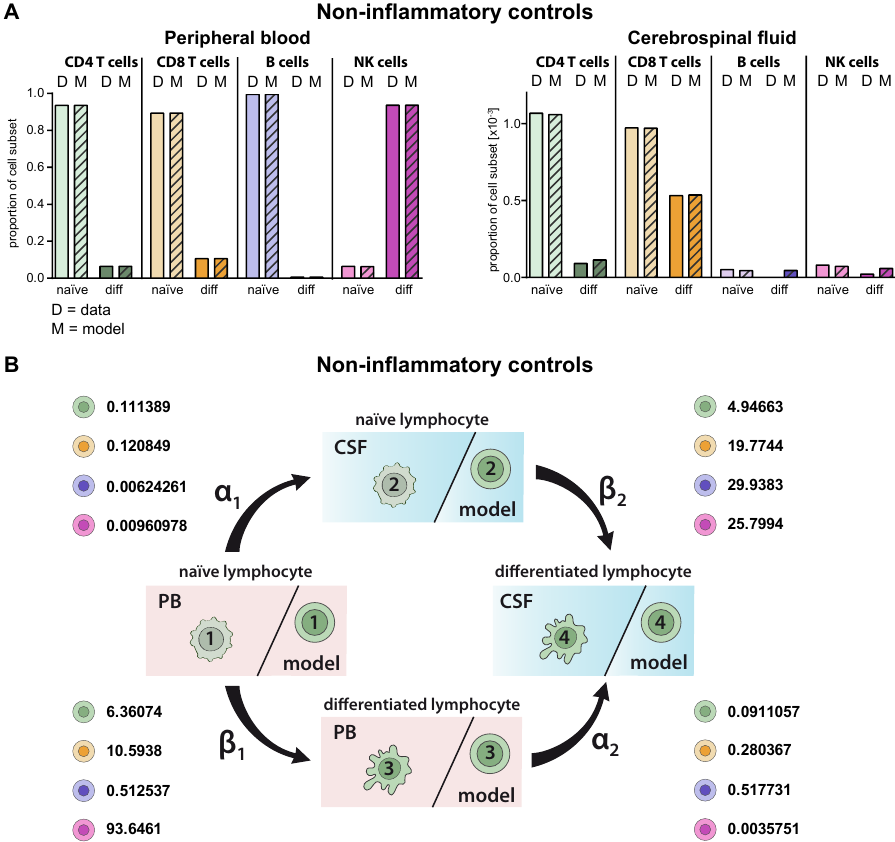
Figure 2. Generation of a model describing the relative distribution of naïve and di ff erentiated lymphocyte subsets in the PB and CSF of non-inflammatory controls. ( A ) Graphs showing the relative abundance of naïve (light colors) and di ff erentiated (di ff , dark colors) lymphocyte subsets (D = data) including CD4 + T cells (green), CD8 + T cells (orange), B cells (violet), and NK cells (purple) in the PB (top) and CSF (bottom) of non-inflammatory controls ( N = 75). Mean values ± SD of data are provided in Table S1. Data were used to derive a model (M = model, hatched bars) for lymphocyte-subset specific di ff erentiation and transmigration into the CSF. ( B ) Rates (%) determined by the model indicating the transitions from (i) naïve lymphocytes in the PB compartment to the CSF compartment ( α 1 ), (ii) naïve lymphocytes to di ff erentiated lymphocytes within the PB ( β 1 ), (iii) di ff erentiated lymphocytes from the PB to the CSF compartment ( α 2 ), and (iv) naïve lymphocytes to di ff erentiated lymphocytes within the CSF ( β 2 ) under steady state conditions are displayed for the respective lymphocyte